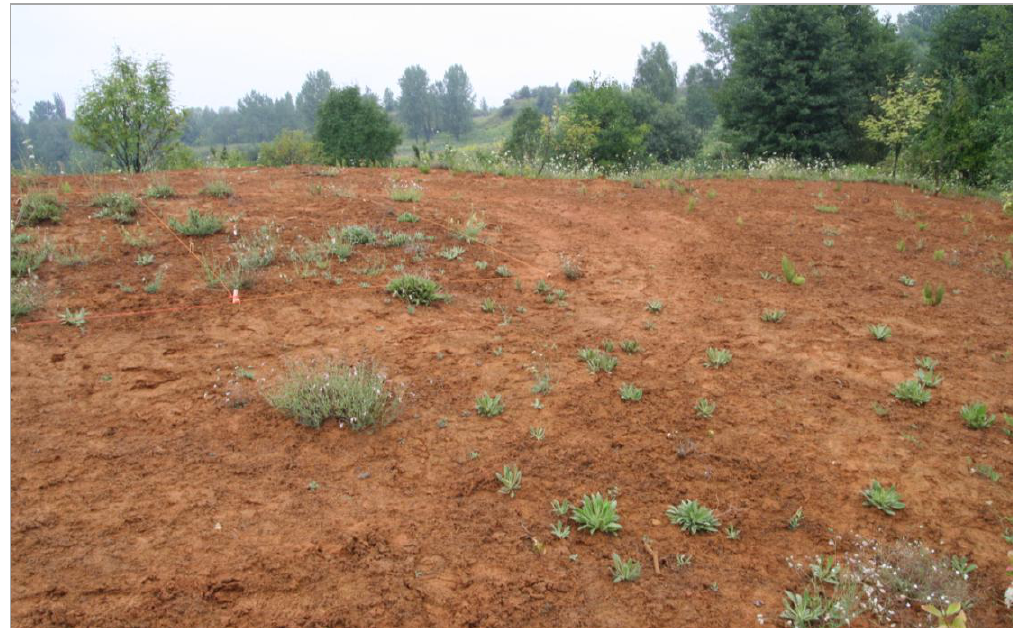
Fig. 14. Current (2014) status of the Biscutella population: seedlings of Biscutella laevigata spreading outside the experimental plots ( A. Rostański